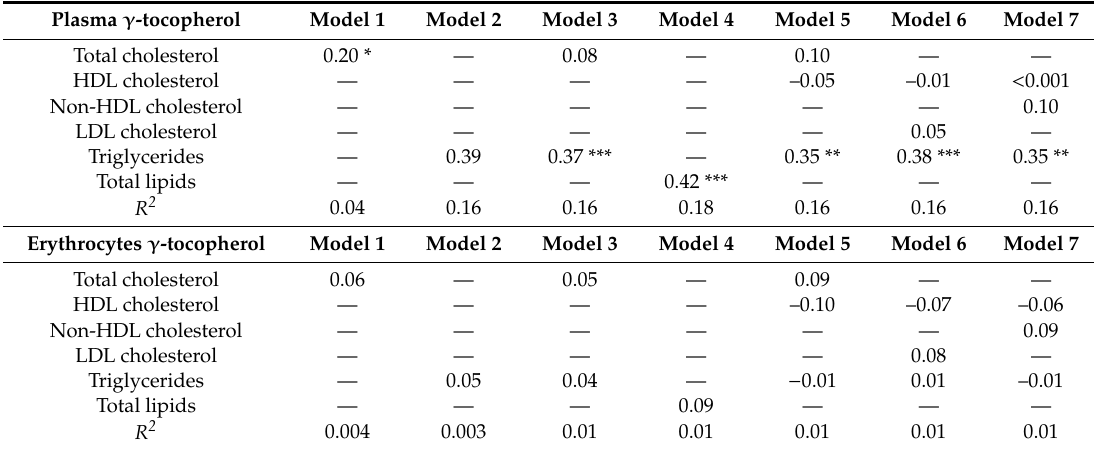
Associations between γ -tocopherol and lipids were tested via univariable and multivariable linear regression analyses of which standardized β coe ffi cients are presented (* p < 0.05, ** p < 0.01, *** p < 0.001).